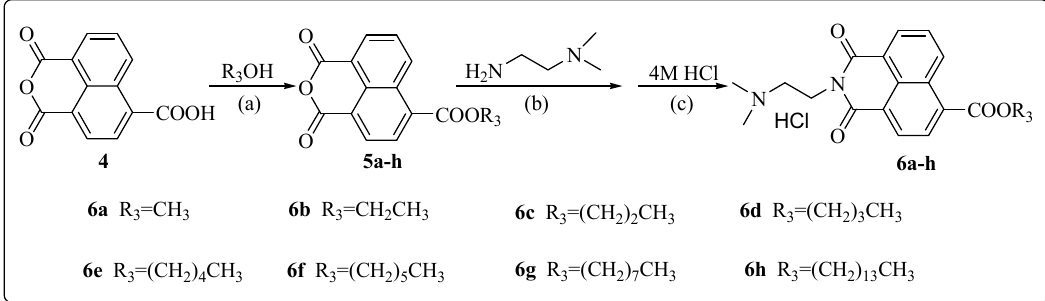
Table 1. Inhibitory results of target compounds against four cancer cell